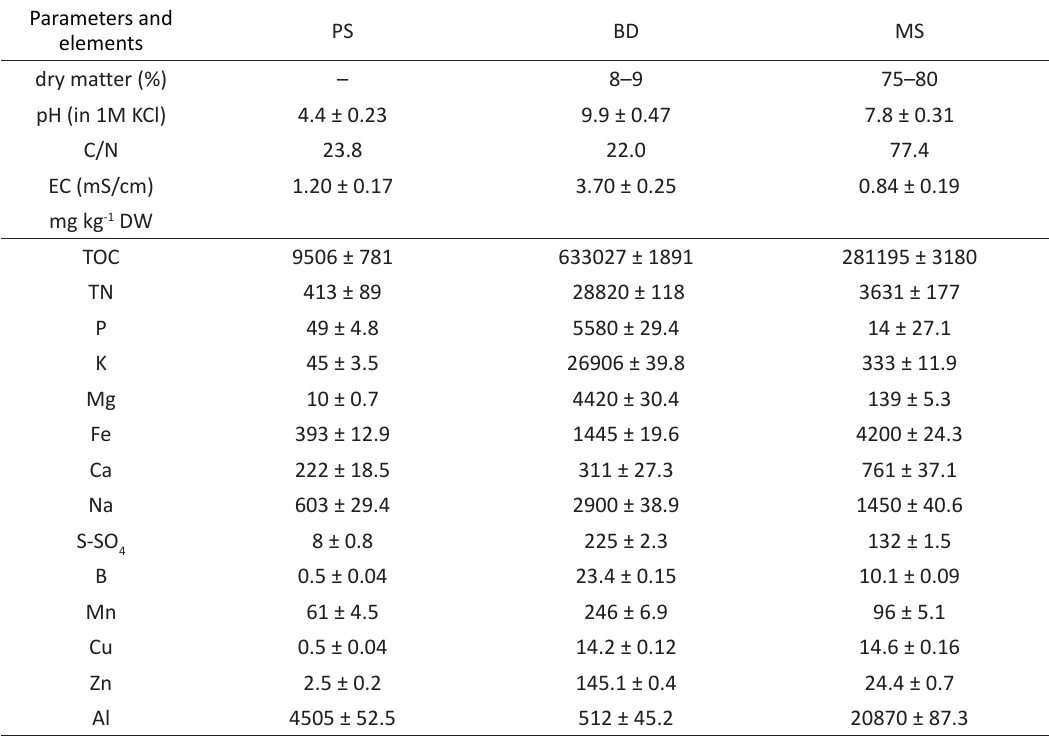
Table 1. Chemical properties of control soil (podzolic soil - PS), biogas digestate (BD) and mining waste (mudstone - MS) used in the experiment (Różyło et al. 2015) (mean ± SD, n = 3) Parameters and elements